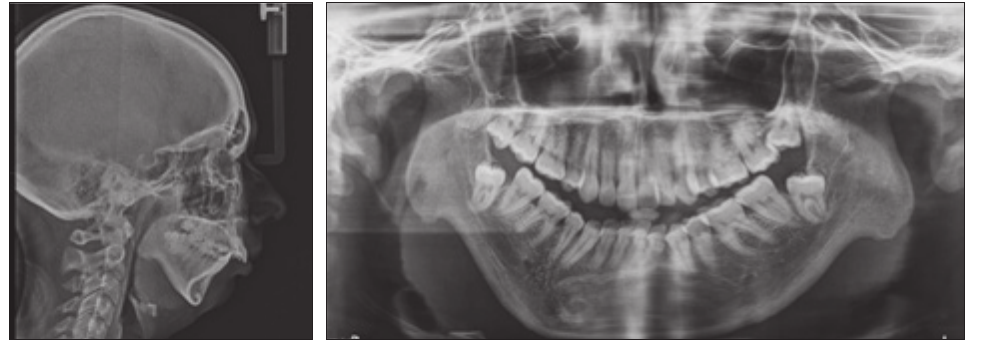
Figure 5. Lateral cephalogram Figure 6. Orthopantomogram following ICR presentation; June following ICR presentation; June 2016.